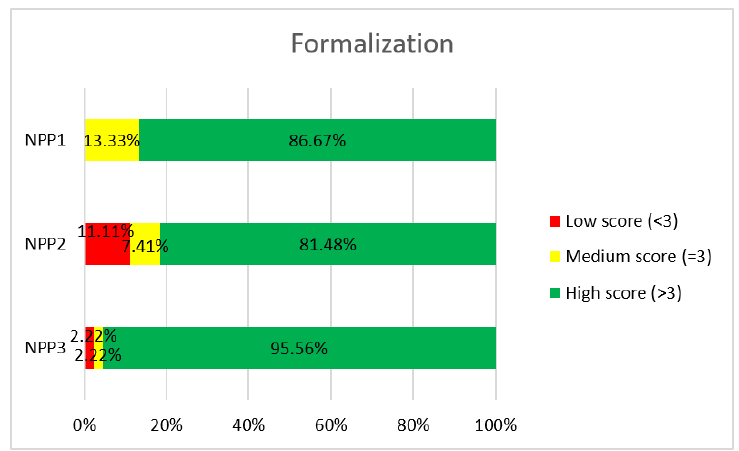
Figure 7. Categorized BARS percentages for formalization, by company.